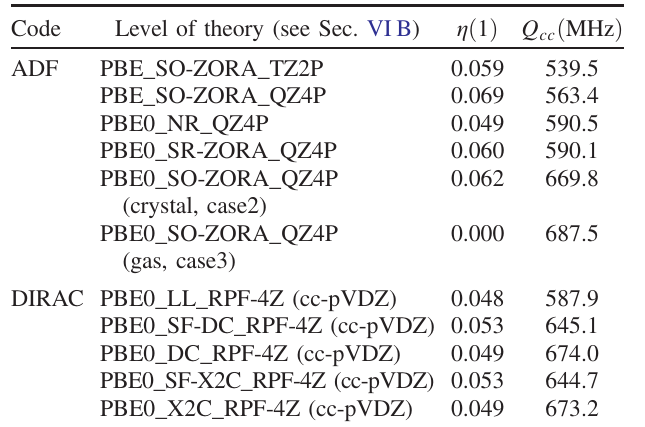
molecule (case 2, if not noted otherwise) due to a better basis set (QZ4P with respect to TZ2P), hybrid PBE0 functional and relativistic spin-orbit coupling (SO-ZORA, X2C, and DC with respect to SR-ZORA, SF-X2C, and SF-DC, respectively). Non- relativistic one- (NR) and four-component (LL) results are displayed for